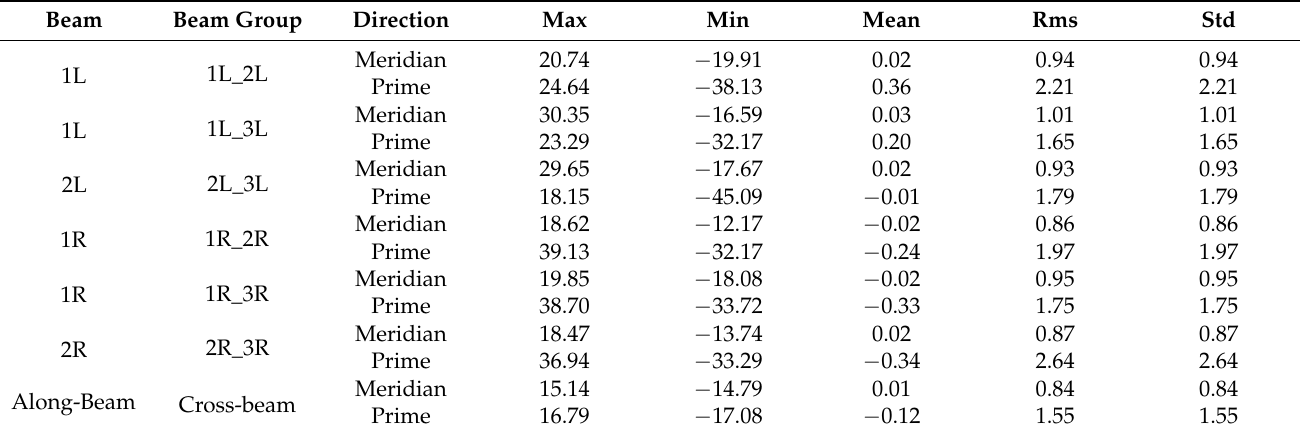
Table 16. Statistics of differences between gridded DOVs calculated by the joint along-cross beam DOVs and the XGM2019e_2159-DOV model (Unit: arc_sec).